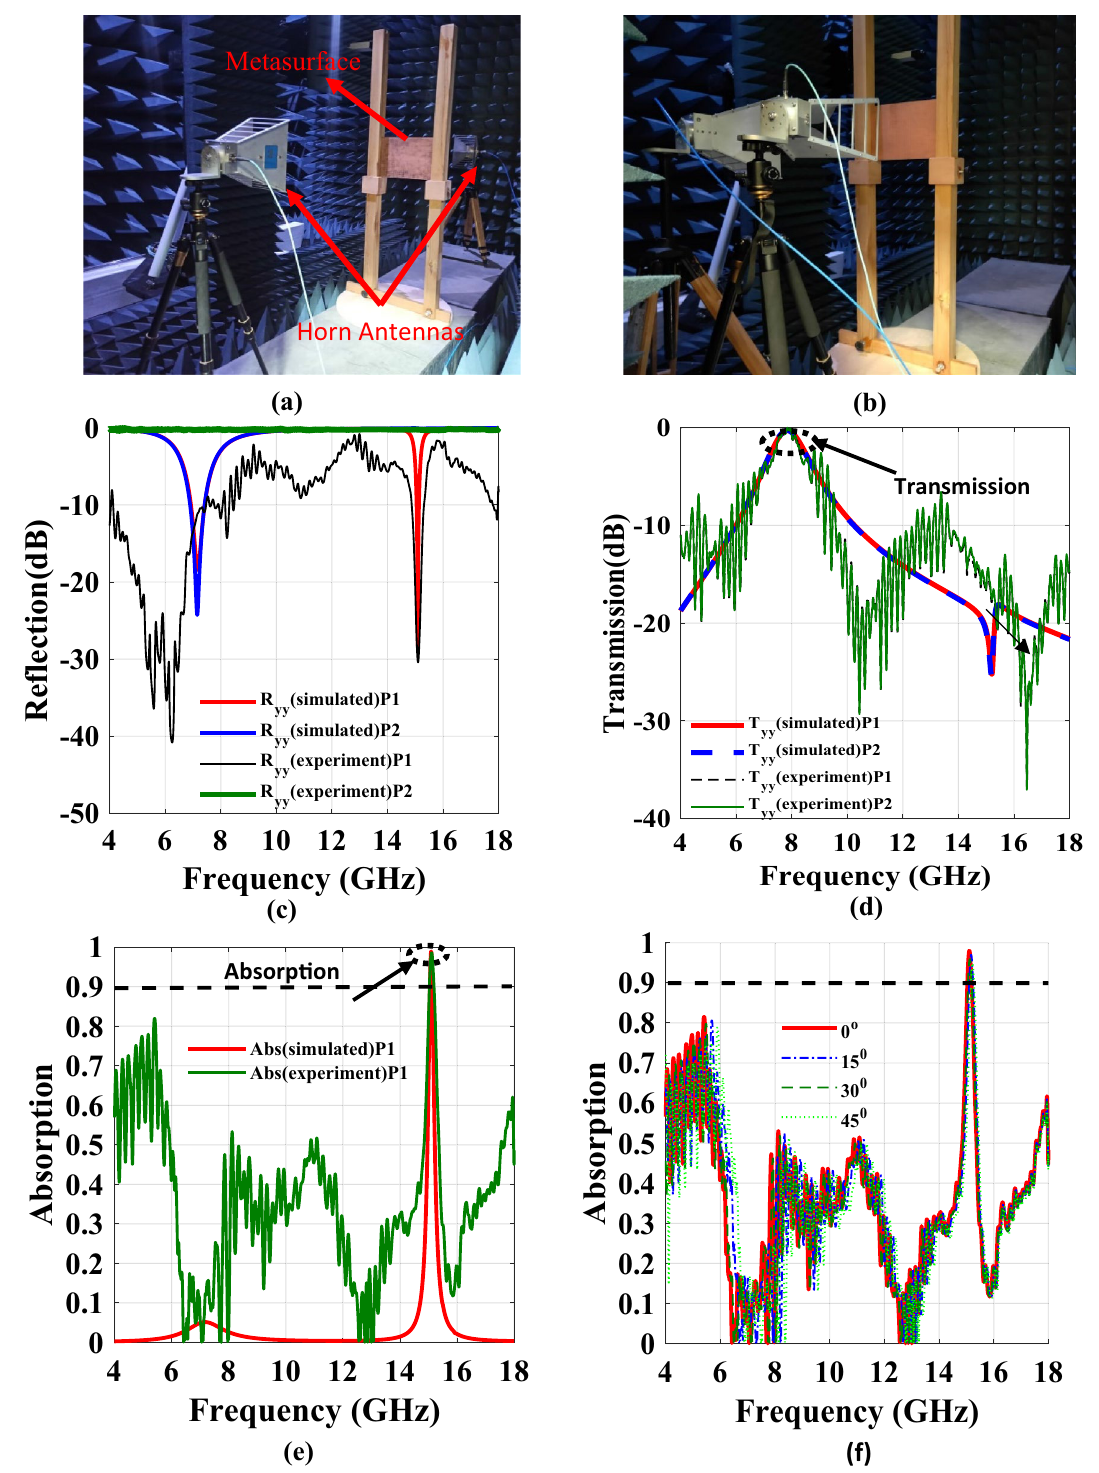
Figure 12. ( a ) Fabricated prototype of metasurface ( b ) Setup for the experimental measurements ( c ) Comparison between simulated and experimented reflections ( d ) Comparison between simulated and experimented transmissions ( e ) Comparison between simulated and experimented absorption ( f ) Experimented Angular Stability. *The Fig. 3c–f are created using MATLAB ver. R2020A-URL: https:// www. mathw orks. com/ produ cts/ matlab.